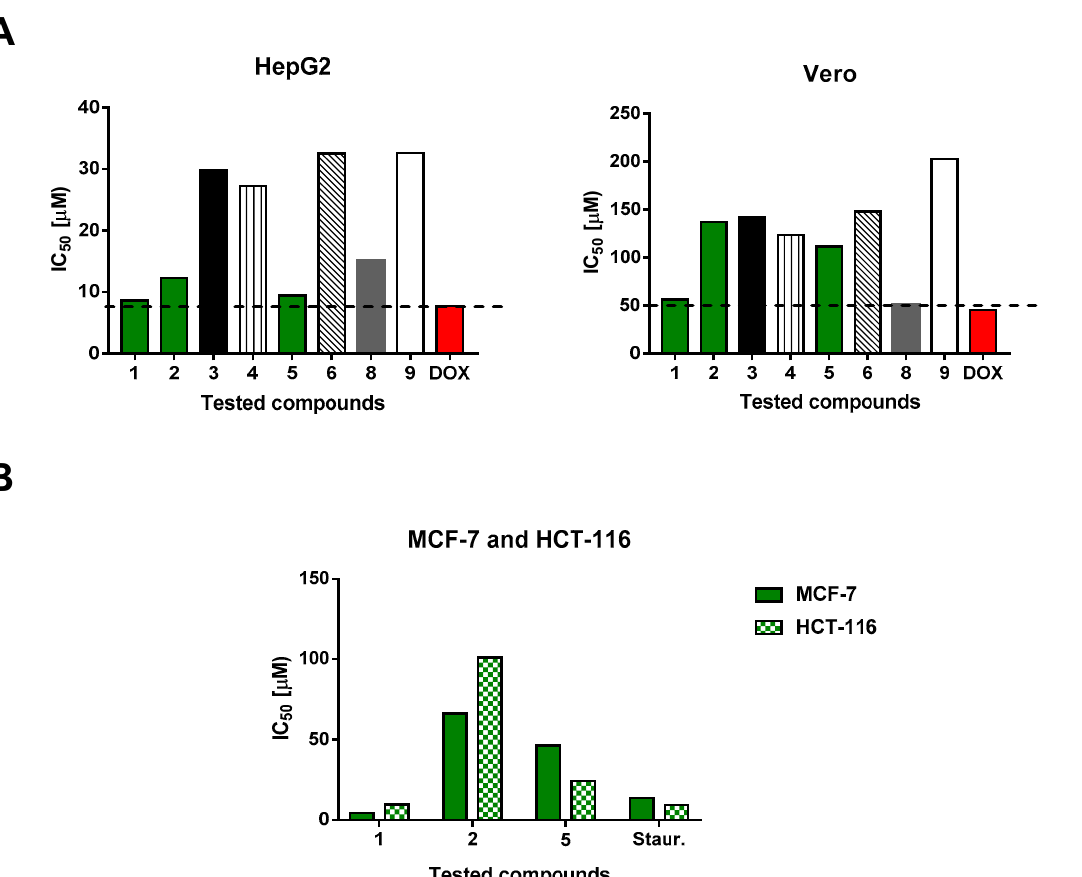
Figure 3. ( A ) Screening of the IC 50 values of the tested compounds against the HepG2 cells and Vero normal cells, and ( B ) IC 50 values of the most active compounds 1 , 2 , 5 and staurosporine (control) against both MCF-7 and HCT-116 cell lines. IC 50 values were calculated using the non-linear regression curve fit of the percentages of cell viabilities with the tested concentrations.